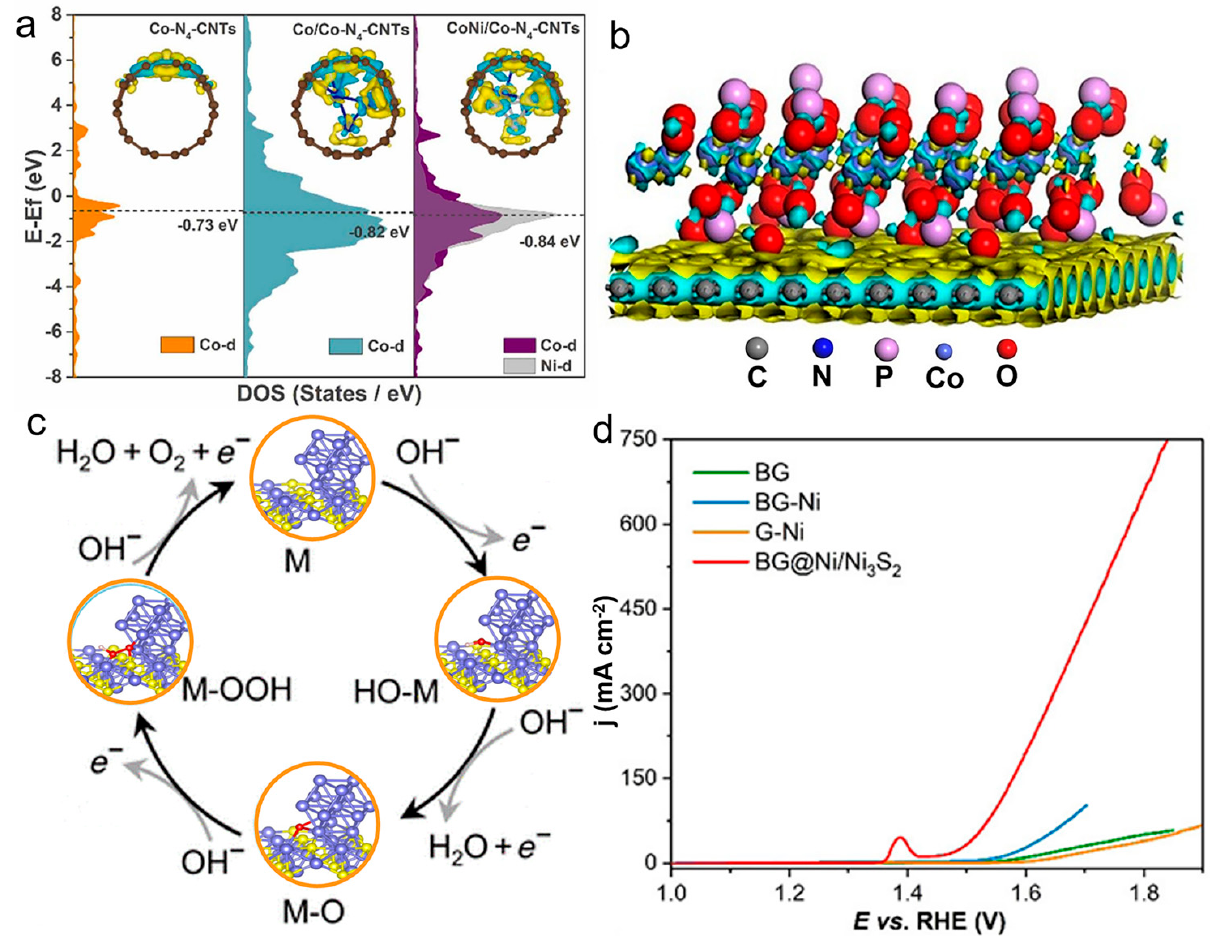
Figure 4. ( a ) Density of states (DOS), charge density redistributions, and d-band centers of Co − based electrocatalysts. Reproduced with permission of [33], copyright 2022 Elsevier. ( b ) The charge density at the interface of Co 2 P 2 O 7 @N, P − C. Reproduced with permission of [39], copyright 2020 Else- vier. ( c ) Schematics of the OER catalytic mechanism for BG@Ni/Ni 3 S 2 . ( d ) Linear sweep voltammetry plots of BG, BG@Ni, G@Ni, and BG@Ni/Ni 3 S 2 in 1.0 M KOH. Reproduced with permission of [41], copyright 2020 ACS Publishers.